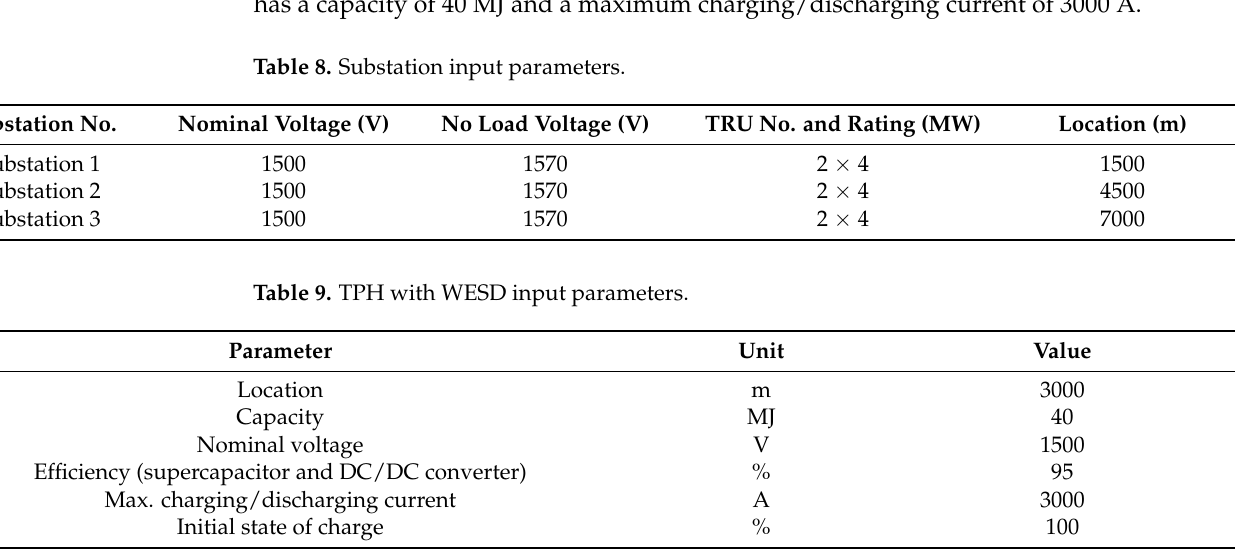
Table 11 present typical train parameters assumed for simulation purposes. A headway of 180 s with a station dwell time of 60 s is